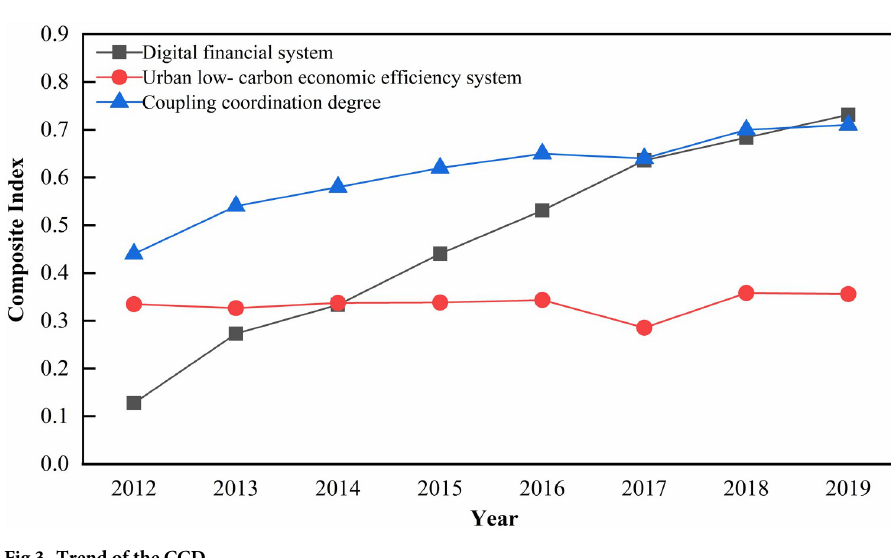
Fig 3. Trend of the CCD.